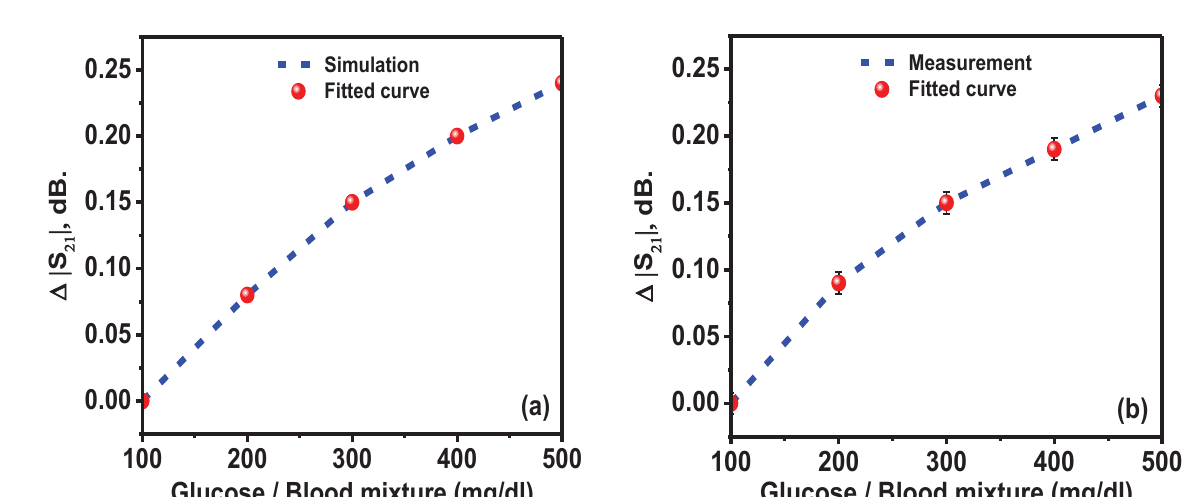
Figure 16. ( a ) Simulated and ( b ) measured transmission level variation, ∆ | S 21 | , dB against the glucose concentration in blood.